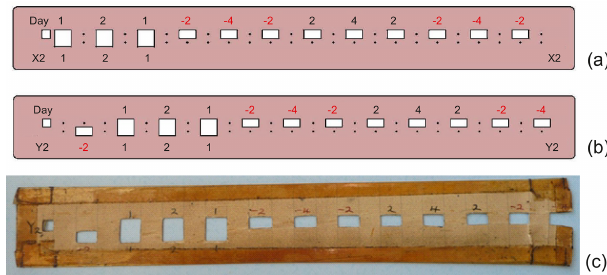
Figure 6. (a) A schematic version of an original cardboard stencil for X2 with holes to show through those hours with data that had to be multiplied either by positive or negative weights. (b) A cor- responding stencil for Y2. (c) An original cardboard stencil for Y2 showing the positive (black) and negative (red) weights. There were many pieces of cardboard like this for the different filters described in Doodson (1928). (Schematic versions courtesy of Ian